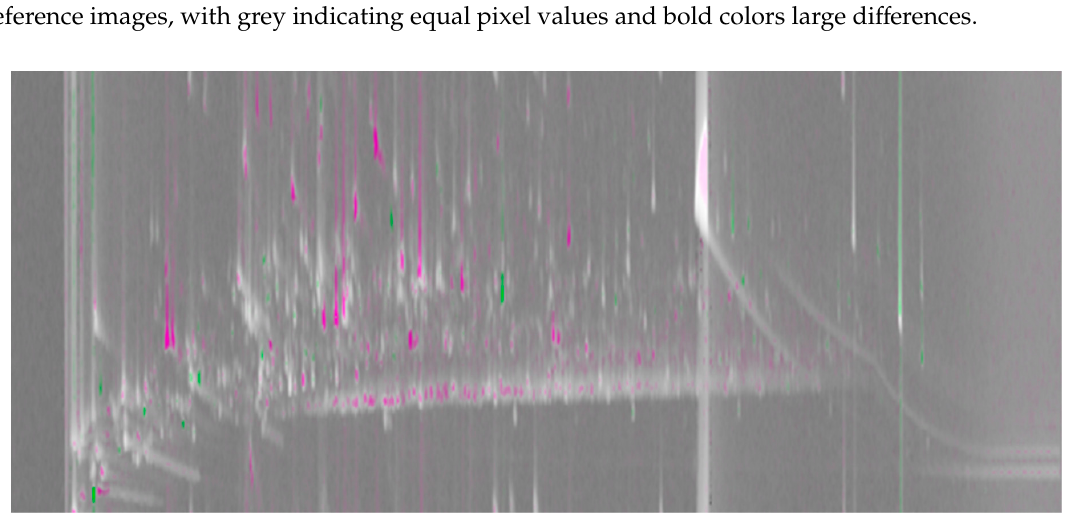
Figure 1. A comparative visualization between composite GC×GC/MS chromatograms of the high (reference image) and low (analyzed image) elevation teas. The magenta and green peak regions show the areas in the chromatogram where relative distribution of common analytes is higher in the high and low elevation teas, respectively. Light grey peak regions correspond to analytes with similar percentage response in the two chromatograms.